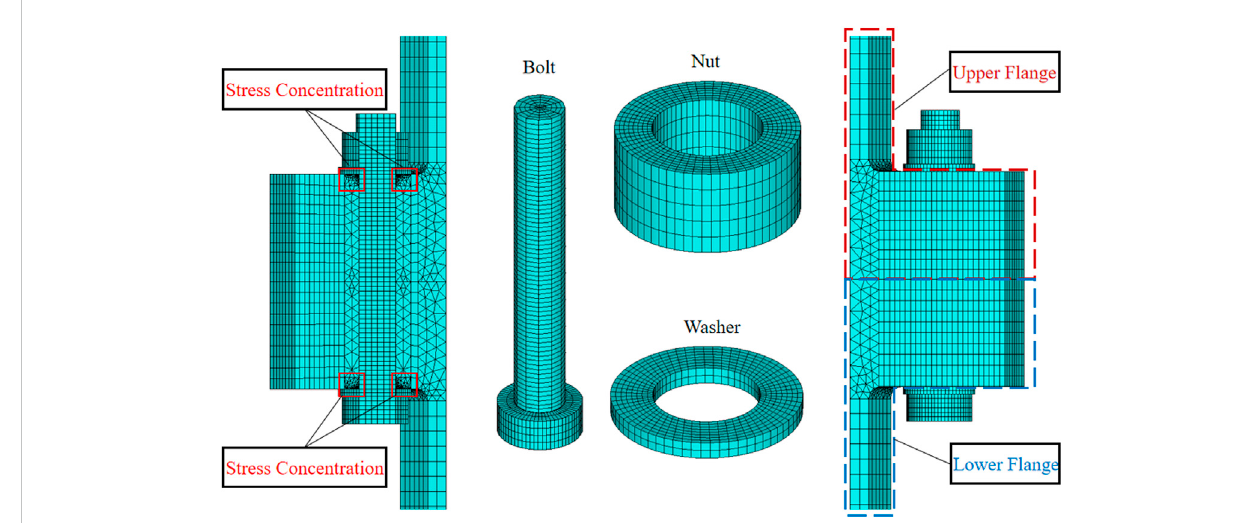
FIGURE 6 Finite-element model of the segment.